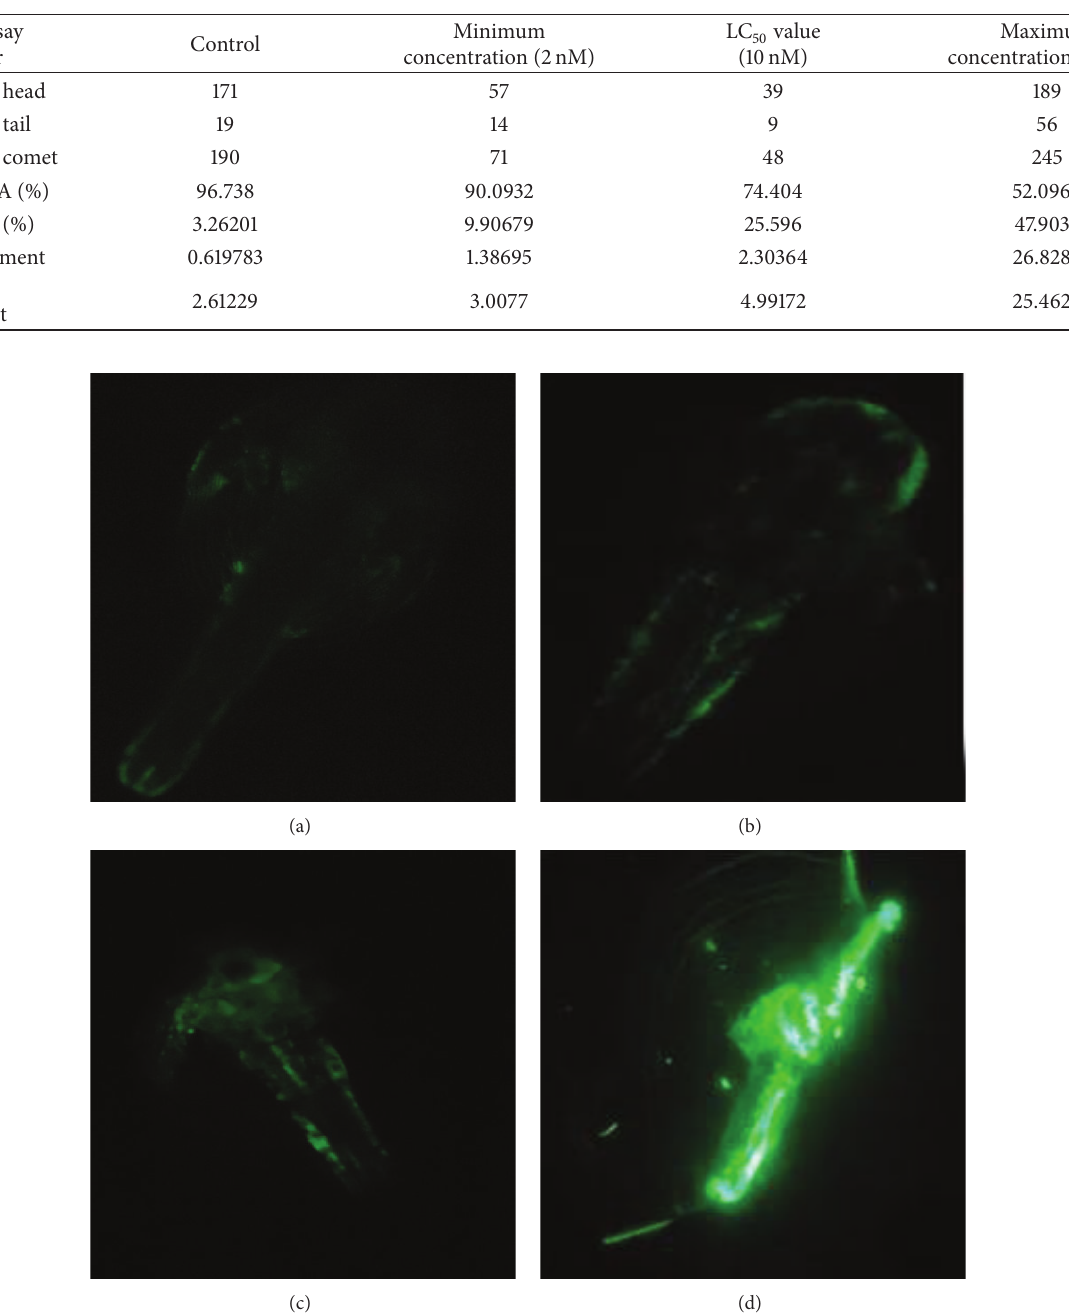
Table 3: Comet assay parameters using CASP software of comet assay.